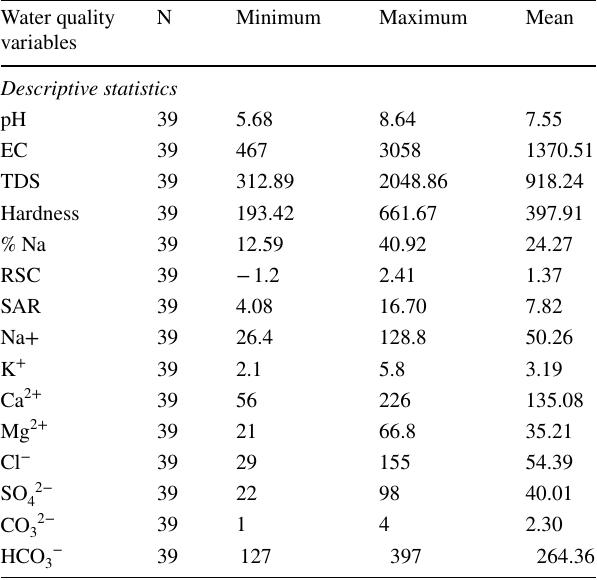
Table 1 Descriptive statistical analysis result of water samples